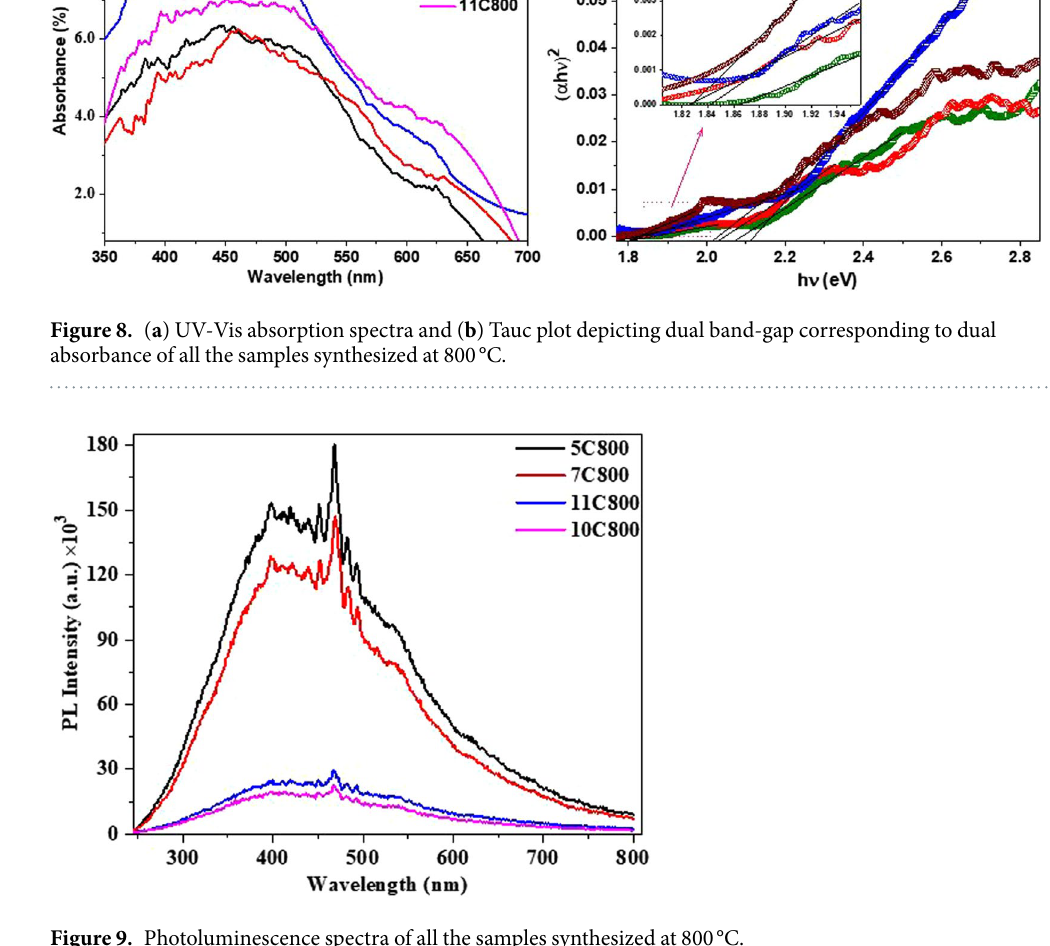
Figure 9. Photoluminescence spectra of all the samples synthesized at 800